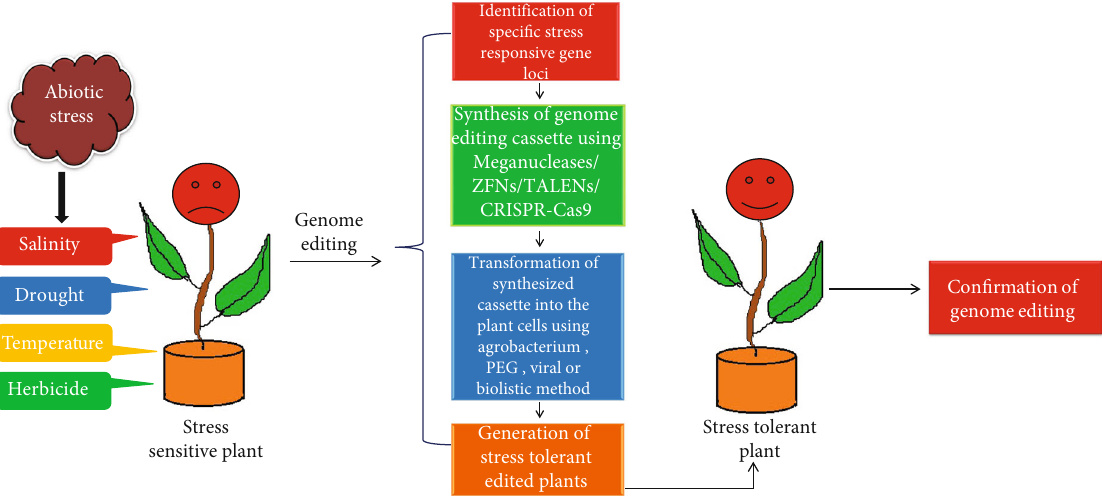
Figure 1: Schematic representation of the process of genome editing for generating abiotic stress-tolerant